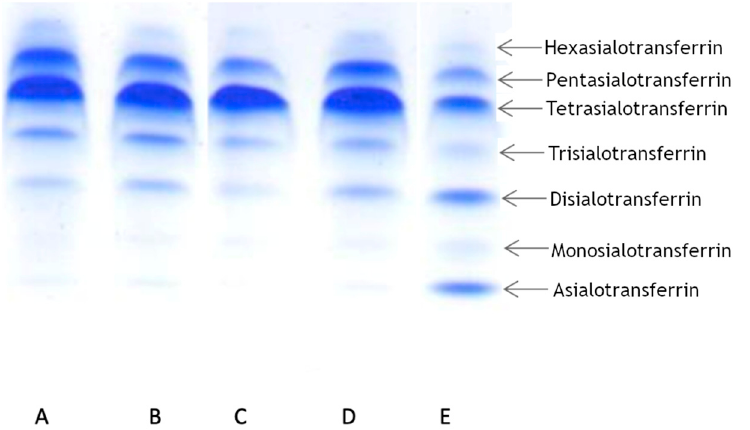
Figure 2. Isoelectric focusing (IEF) of transferrin in patients with ALG13 c.320A>G variant. ( A ) Patient 3: normal profile; ( B ) Patient 3 (another sample): slight increase of disialotransferrin; ( C ) Patient 1: normal profile; ( D ) Patient 2: mild pattern of type I; ( E ) Positive control (CDG type I).